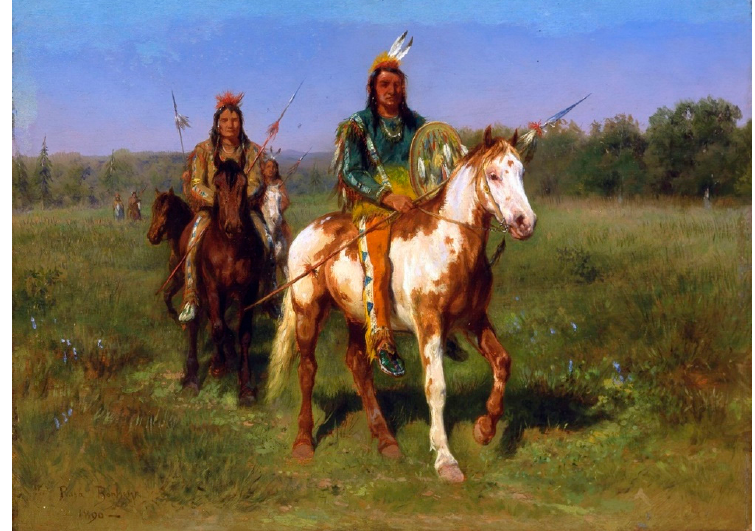
Figure 19. Rosa Bonheur, Mounted Indians Carrying Spears , 1890, oil on board, Whitney Gallery of